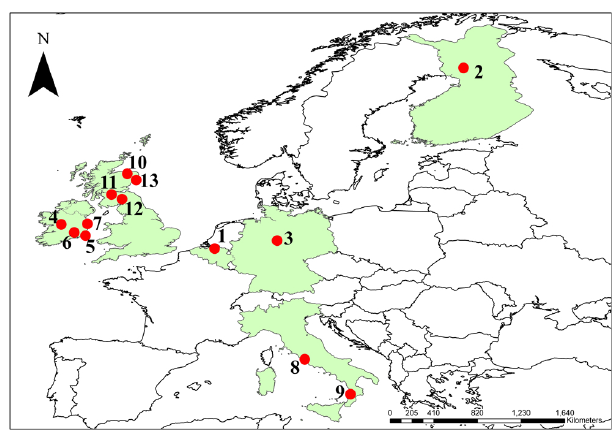
Fig. 2. Case study locations (numbers correspond with Table